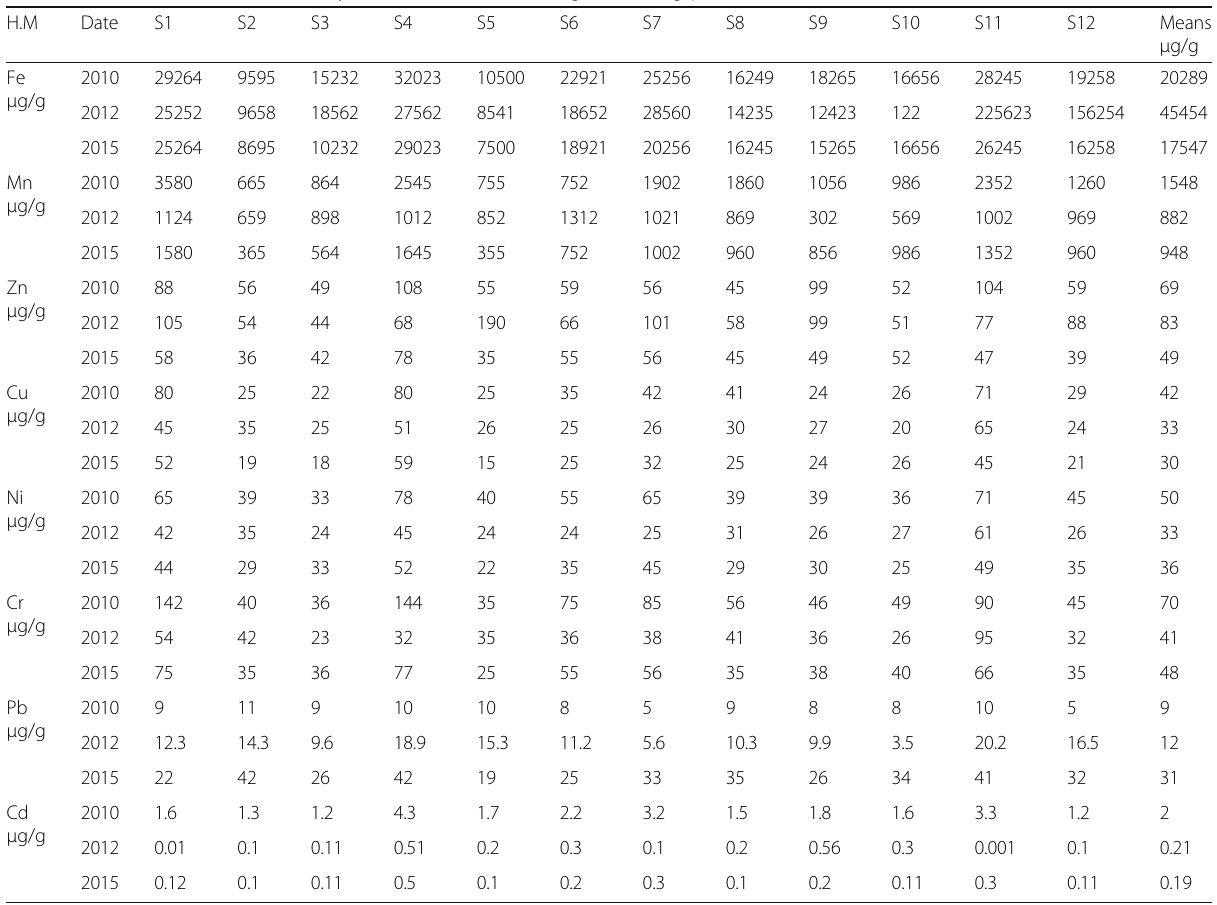
Table 10 The concentration of heavy metals of EL-Burullus Lagoon during periods of 2010, 2012, and 2015 H.M